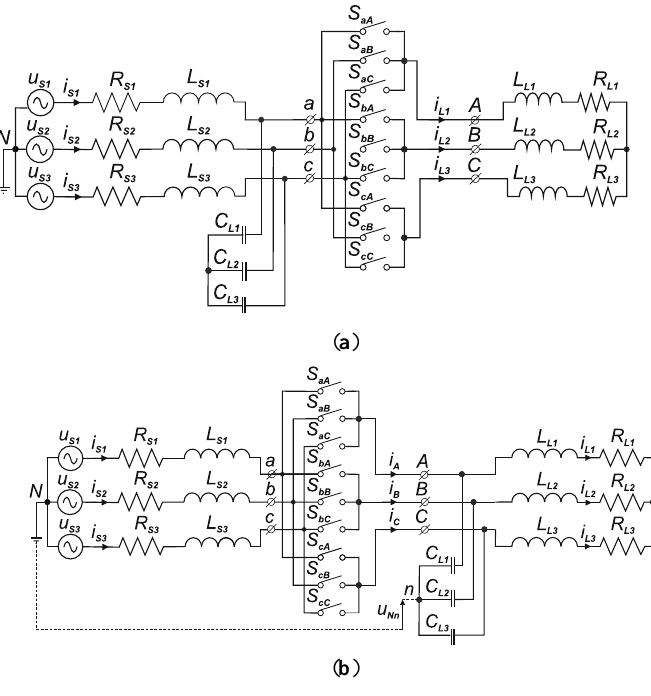
Figure 1. Schematic diagram of the converter: ( a ) voltage; ( b ) current.